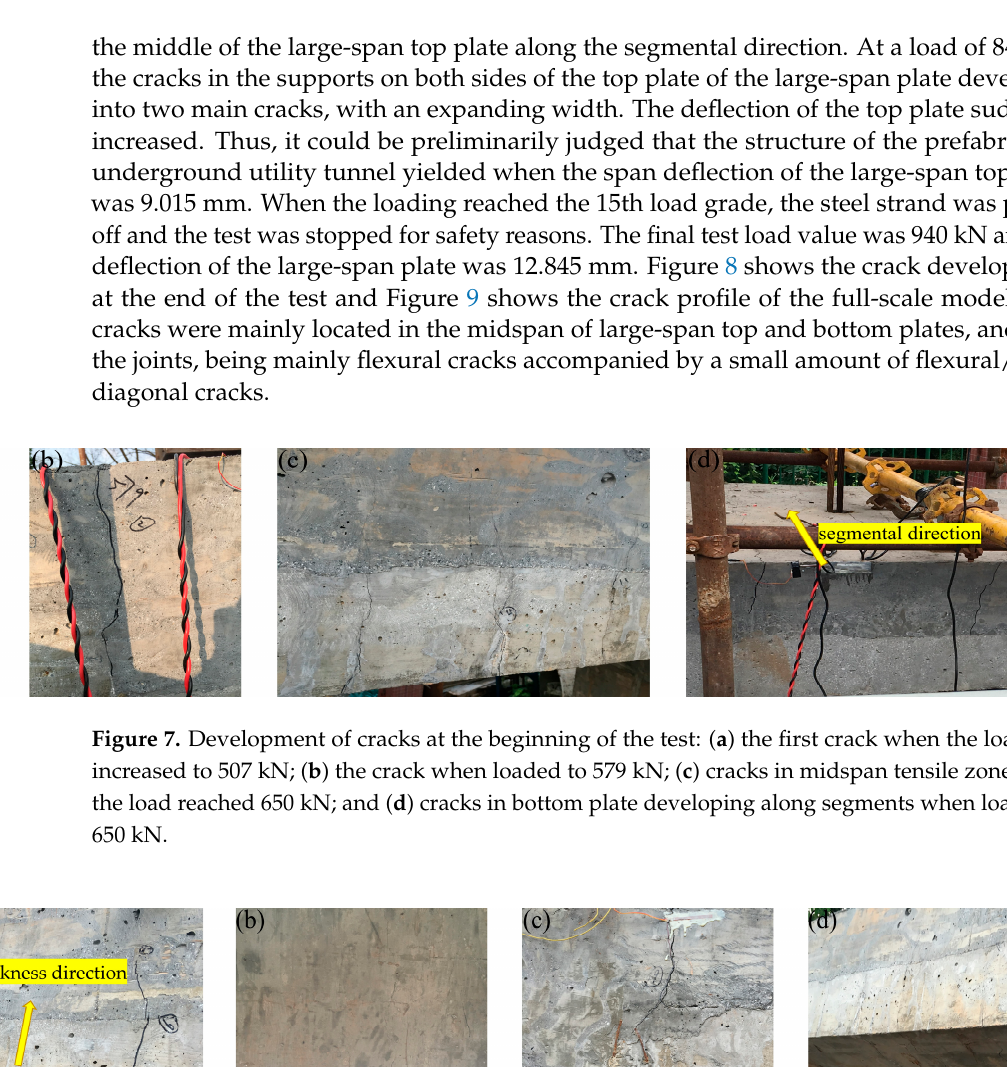
Figure 7. Development of cracks at the beginning of the test: ( a ) the first crack when the load was increased to 507 kN; ( b ) the crack when loaded to 579 kN; ( c ) cracks in midspan tensile zone when the load reached 650 kN; and ( d ) cracks in bottom plate developing along segments when loaded to 650 kN.